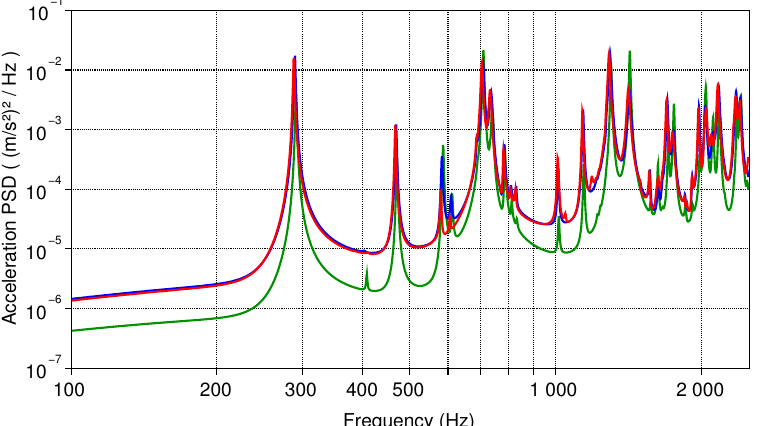
Figure 8. HB–2 structural response (acceleration PSD) at the center of the envelope, point (a) in Figure 6, simulated using the FEM model alone (green), the BEM subsystem of the external air volume (blue) and the BEM subsystem of both internal and external air volumes (red).